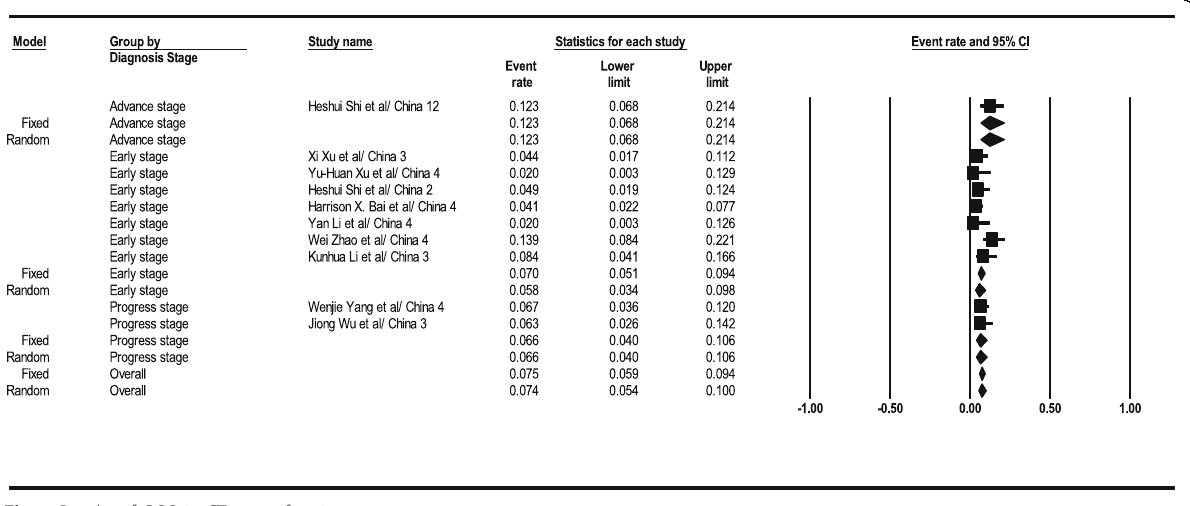
Fig. 7 Results of GGO in CT scan of